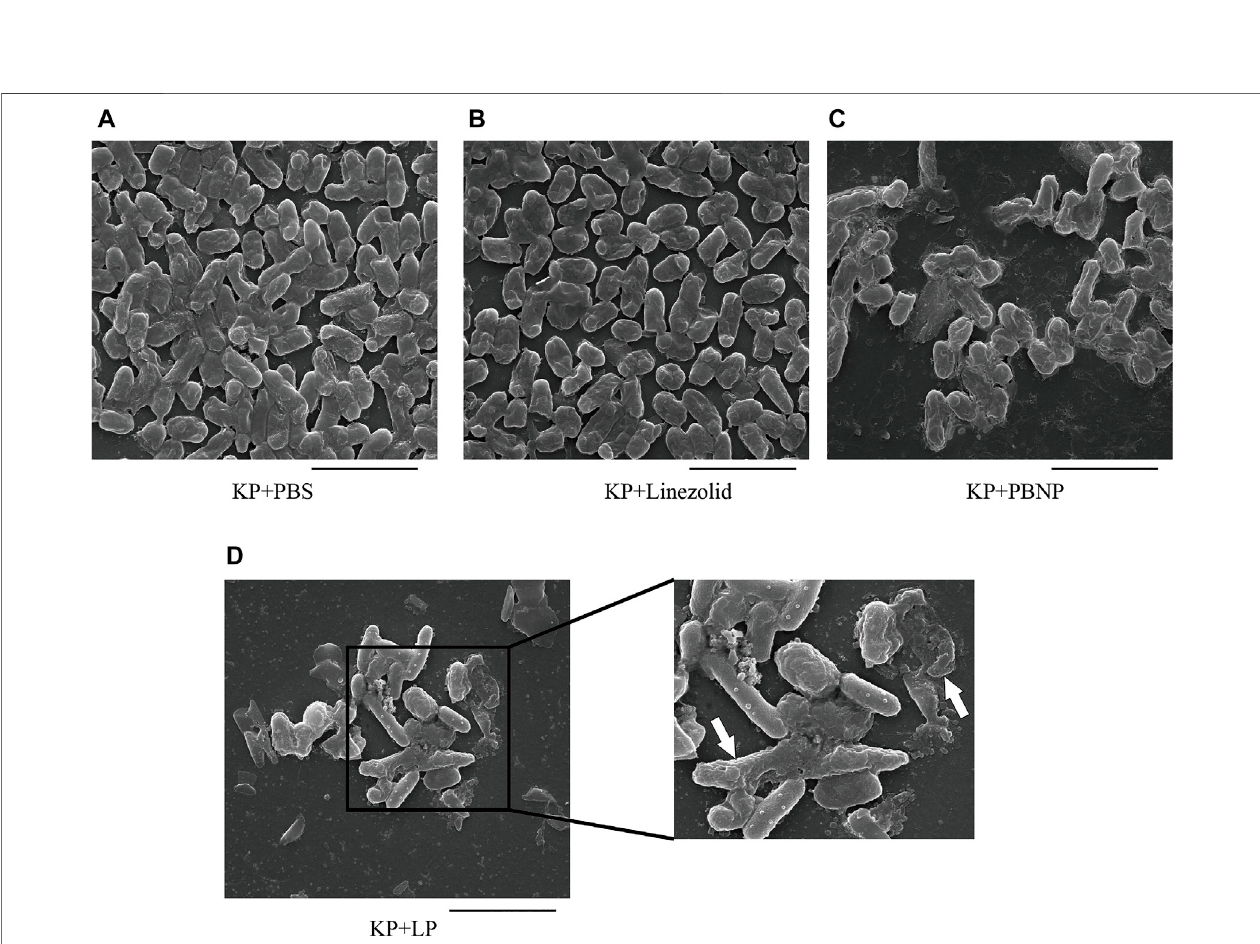
FIGURE3| Themorphologyof K.pneumoniae treatedbyLP (A – D) 1×10 5 CFUofKPWTwereseededin24-wellplatesandtreatedwithPBS (A) ,linezolid(16 μ g/ ml) (B) ,PBNP(8 μ g/ml) (C) orLP (D) for12 h. ThemorphologyofKPWTwasdetected byscanningelectron microscopy (SEM).The destroyedKPWTisindicatedbythe arrow. Scale bar, 5 μ m. All the experiments were performed in